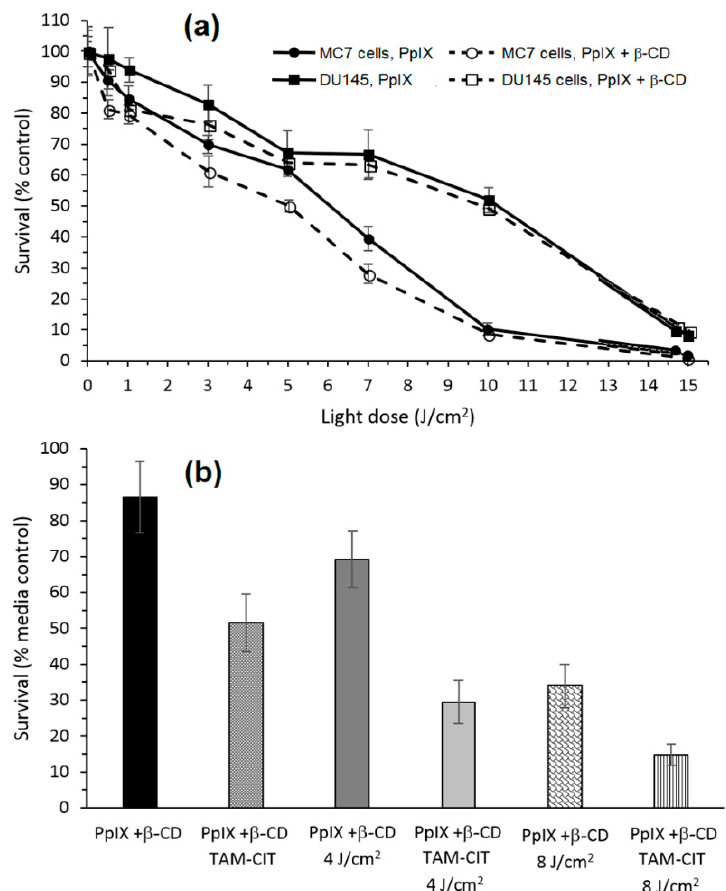
Figure 26. ( a ) Phototoxicity 24 h following 3 h of cell incubation with 7 µM of protoporphyrin IX (PpIX) and PpIX+ β -CD and irradiation through a Schott RG610 long-pass filter (LD 50 values for PpIX were 10 J/cm 2 and 7 J/cm 2 for MCF7 and DU145 cells, respectively, whereas the corresponding values for PpIX+ β -CD were 10 J/cm 2 and 6 J/cm 2 , respectively). ( b ) Bimodal action of PpIX+ β -CD complexed with tamoxifen citrate (TAM-CIT) in MCF7 cells. Phototoxicity 48 h following 3 h of cell incubation with 7 µ M of PpIX+ β -CD and PpIX+ β -CD complexed with TAM-CIT and irradiation through a Schott RG610 long-pass filter at 4 J/cm 2 and 8 J/cm 2 . Adapted from Aggelidou; Theodossiou; Yannakopoulou [144].